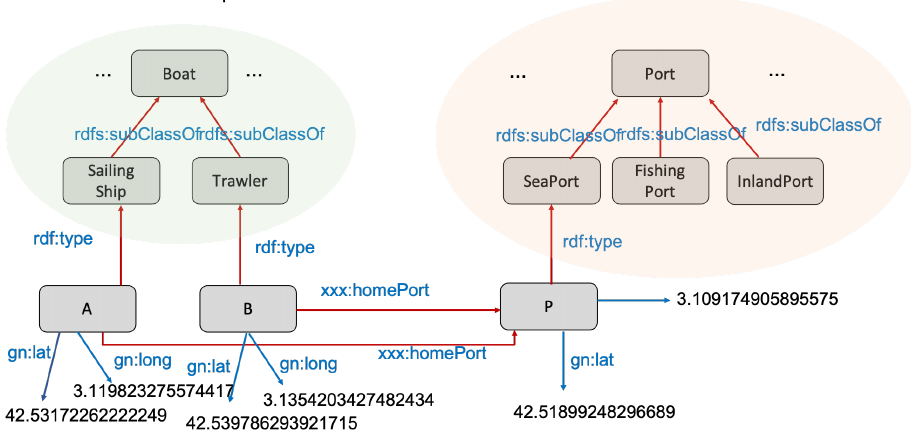
Figure 5. An STK-graph extending the K-graph of Figure 4. Spatial knowledge (predicates in blue) has been added as the latitude and longitude coordinates of the port P and boats A and B , using the geonames ontology (https://www.geonames.org/ontology/documentation.html (accessed on 1 August 2021)) (prefix gn is used). We suppose that time is contextual to the K-graph and corresponds to 12 July 2021 at 2:33 p.m. and 22 s, UTC